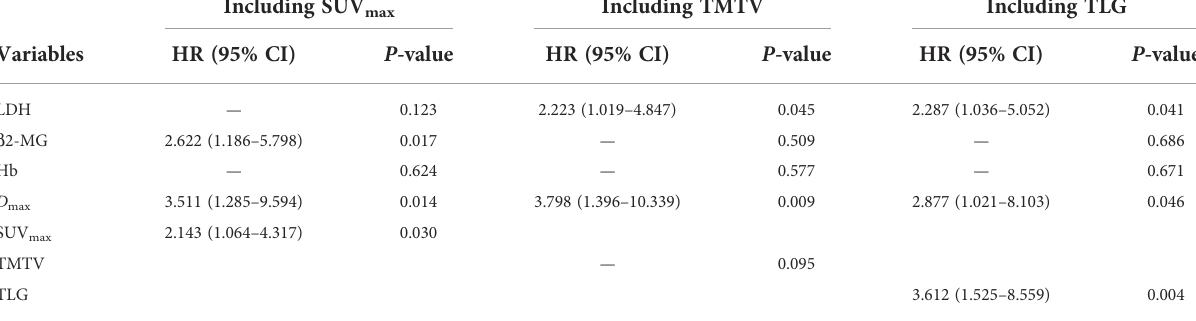
TABLE 3 Multivariate analysis of variables predictive of